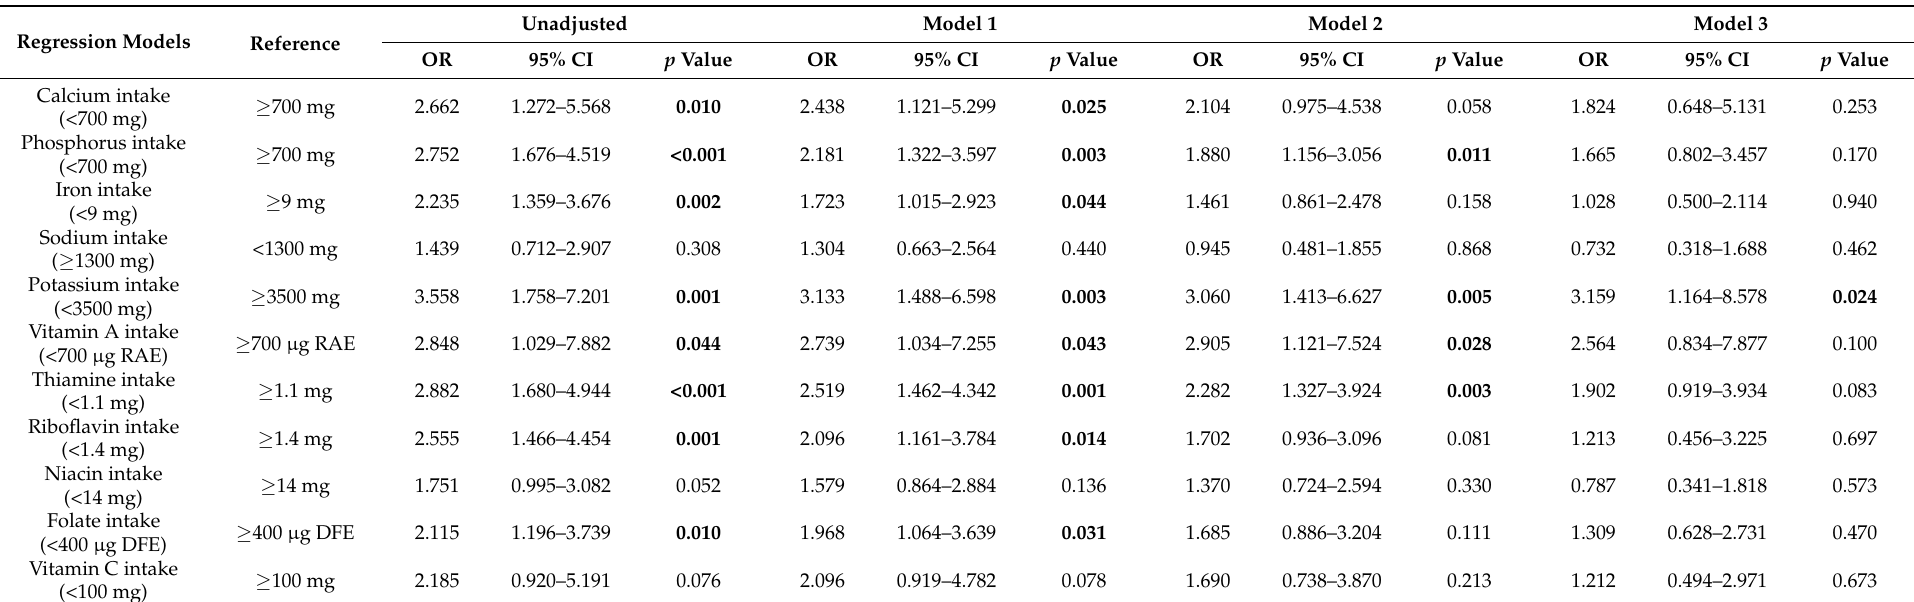
Table 3. Multiple logistic regression for low handgrip strength in men aged ≥ 65